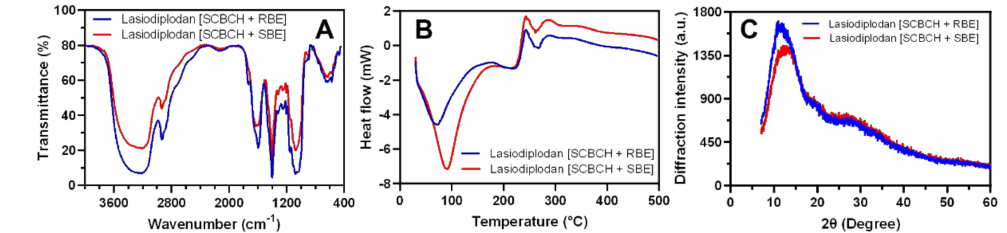
Figure 7. Spectra of lasiodiplodan samples using ( A ) FTIR; ( B ) DSC; ( C )